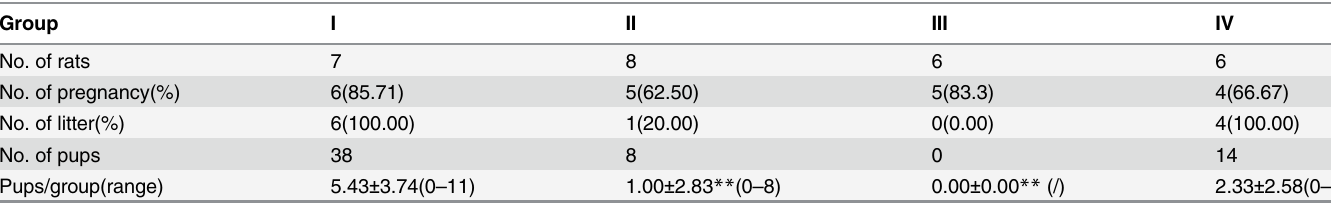
Table 1. Fecundity of the rats.